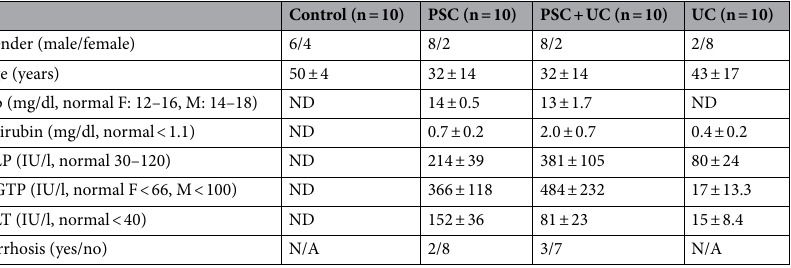
Table 2. Demographic and laboratory features of patients in whom colonic tissue, S1P serum concentration and miR-506 serum expression were analyzed. Values are given as mean ± SD, unless stated otherwise. PSC primary sclerosing cholangitis, UC ulcerative colitis, Hb hemoglobin, ALP alkaline phosphatase, GGTP gamma-glutamyl transferase, ALT alanine aminotransferase, SD standard deviation, N/A not applicable, ND no data.